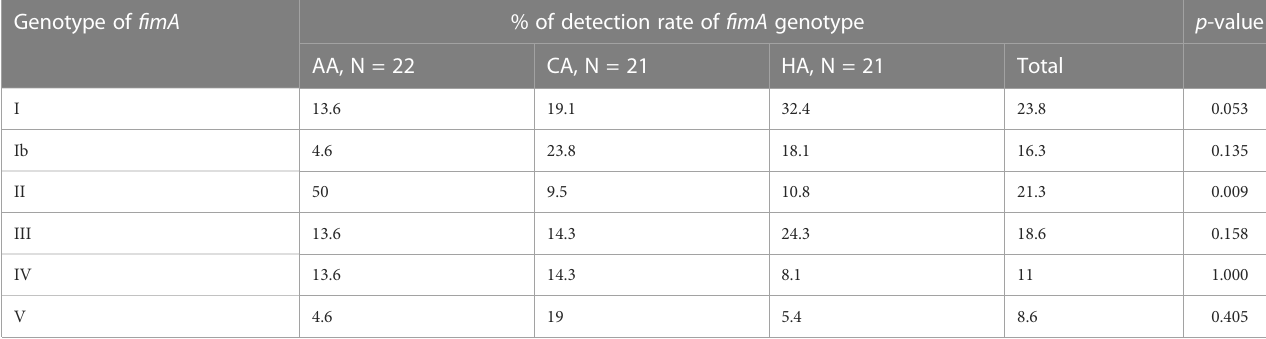
TABLE 5 Distribution of P. gingivalis fi mA genotypes among different racial/ethnic groups. Genotype of fi mA